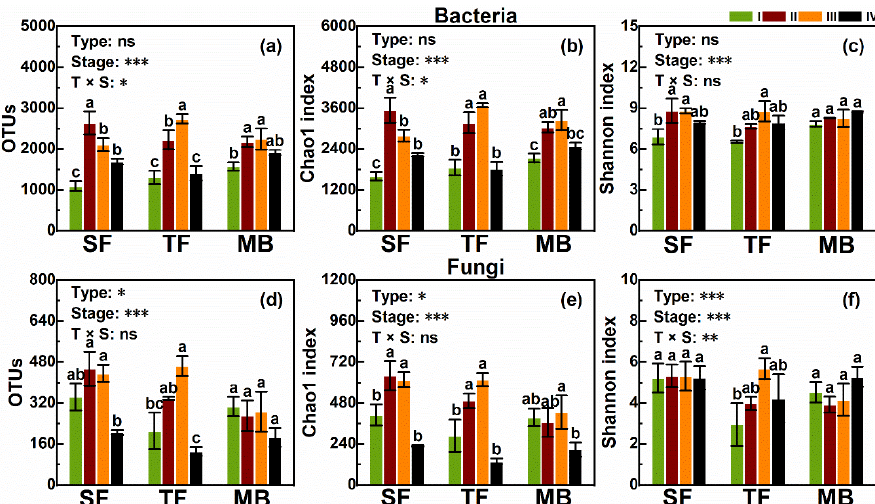
Figure 3. Community diversity of bacteria ( a – c ) and fungi ( e , f ) at the four stages of litter decomposition (I, II, III and IV) in the three forest types. The codes for forest types are described as in Figure 1. Mean, SE ( n = 9) and the significance levels ( *** p < 0.001, ** p < 0.01, * p < 0.05, and ns p > 0.05) of two ‐ way ANOVAs are also given. Different letters indicate significant differences between the four stages within a forest type.